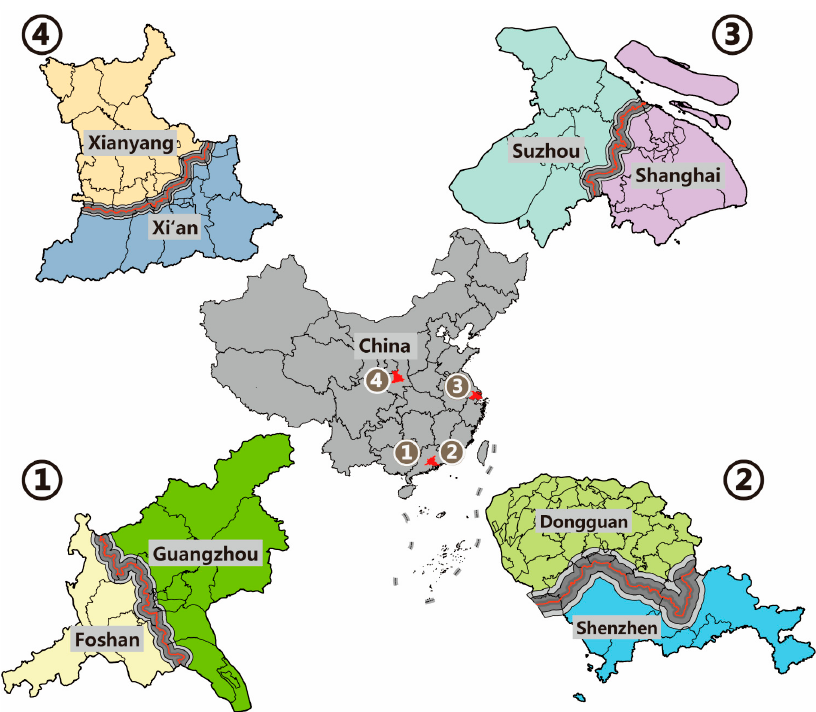
Figure 1. Location distribution of four integrated cities in China: Guangfo City ( 1 ), Guanshen City ( 2 ), Husu City ( 3 ), and Xixian City ( 4 ).